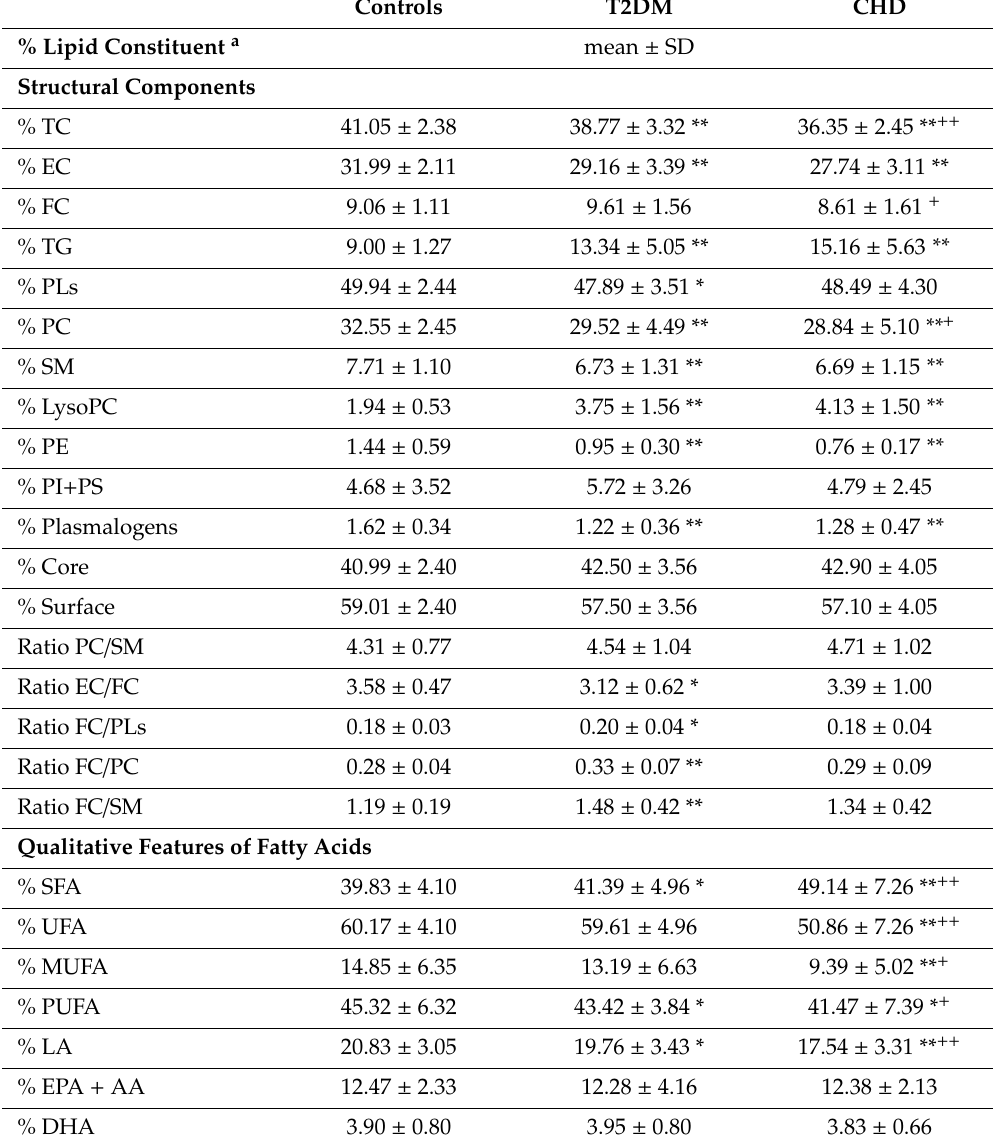
Table 3. Targeted analysis (lipid quantification) of HDL lipoproteins of the studied groups.